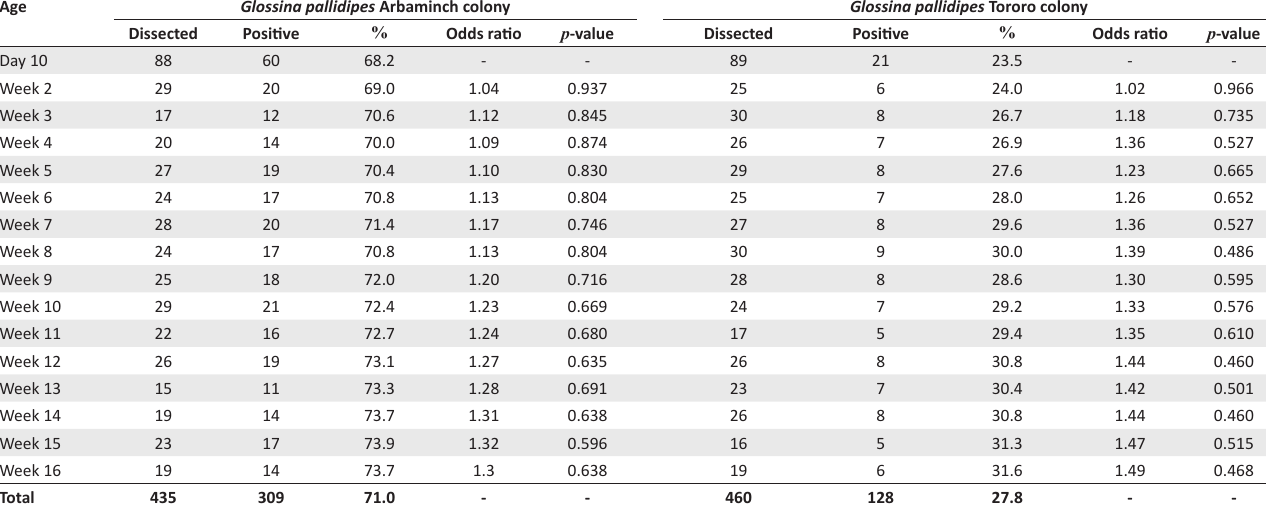
TABLE 3: Effect of age on the prevalence of Glossina pallidipes salivary gland hyperplasia in Glossina pallidipes Arbaminch and Glossina pallidipes Tororo laboratory colonies (standard membrane feeding).